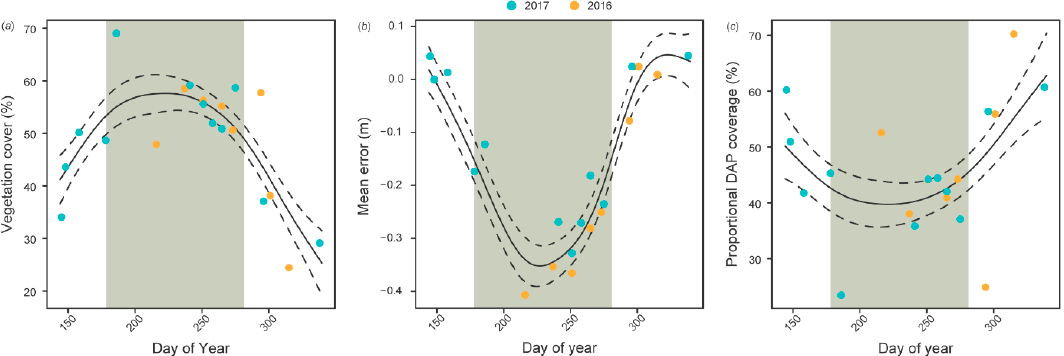
Figure 5. Generalized additive mixed models for ( a ) vegetation cover, ( b ) mean error, and ( c ) proportional DAP coverage. Solid curved line indicates the fitted generalized additive mixed model (GAMM) and dashed lines indicated standard error bounds. Green backdrop from day 178 to 281 indicate locations where mean DTM error exceeded 15 cm.